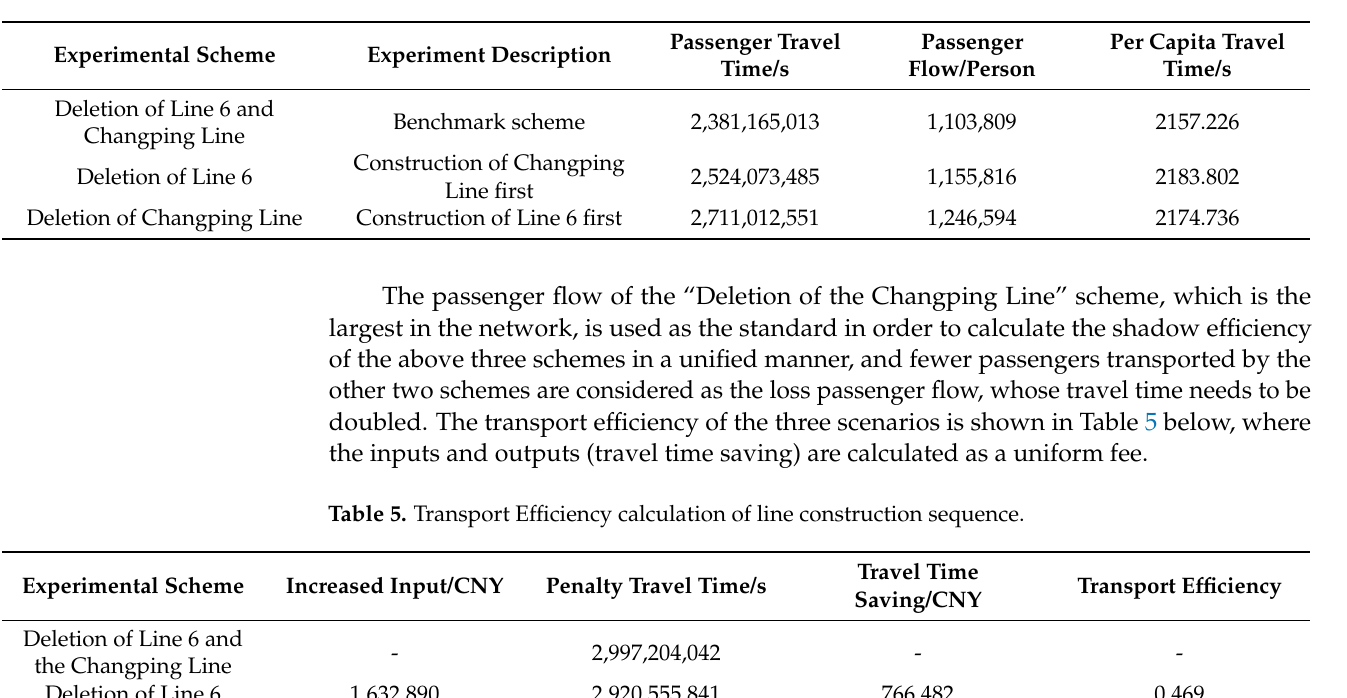
Table 4. Simulation results of line construction sequence.